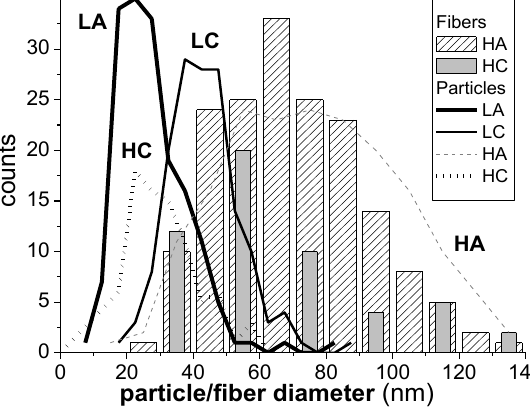
Figure 5. Distributions of the particle (lines) and fiber (bars) diameters, in the coated layers, determined from AFM.